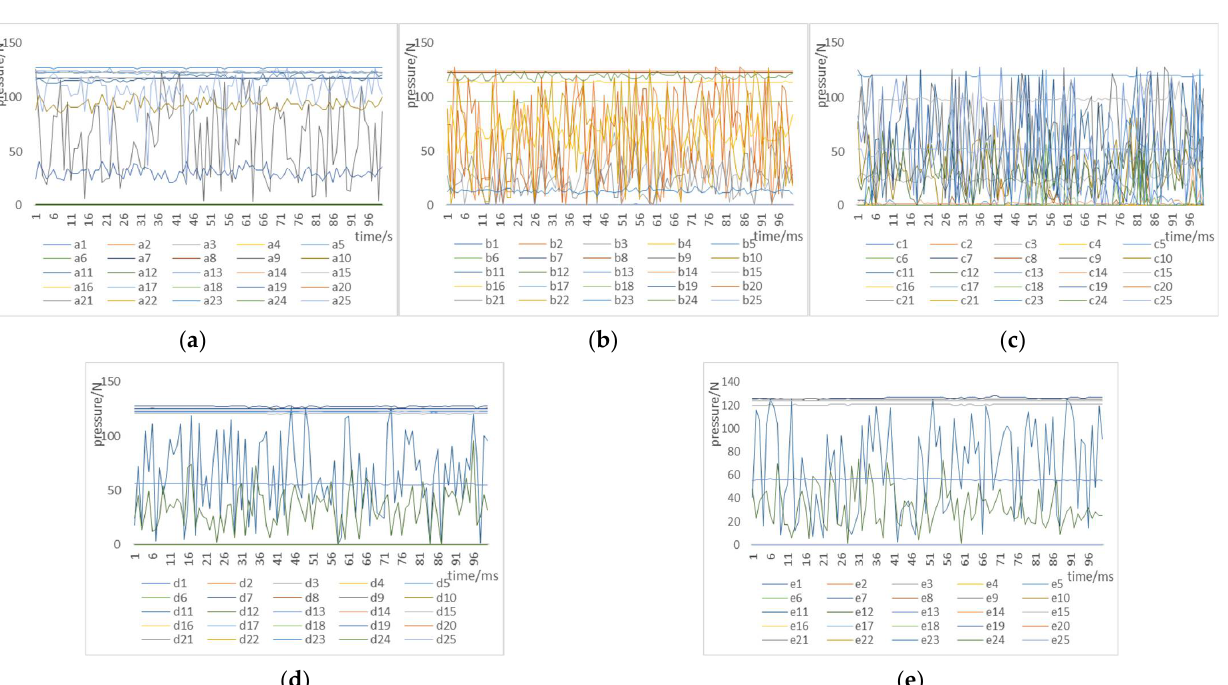
Figure 4. Dataset collection experiment.